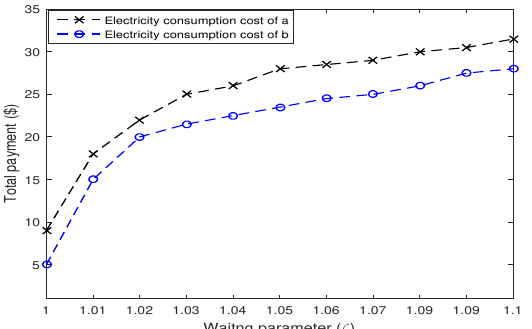
Figure 4. The impact of changing ζ on electricity cost and delay time. The trade-off is evident. Total cost and delay time versus parameter ζ